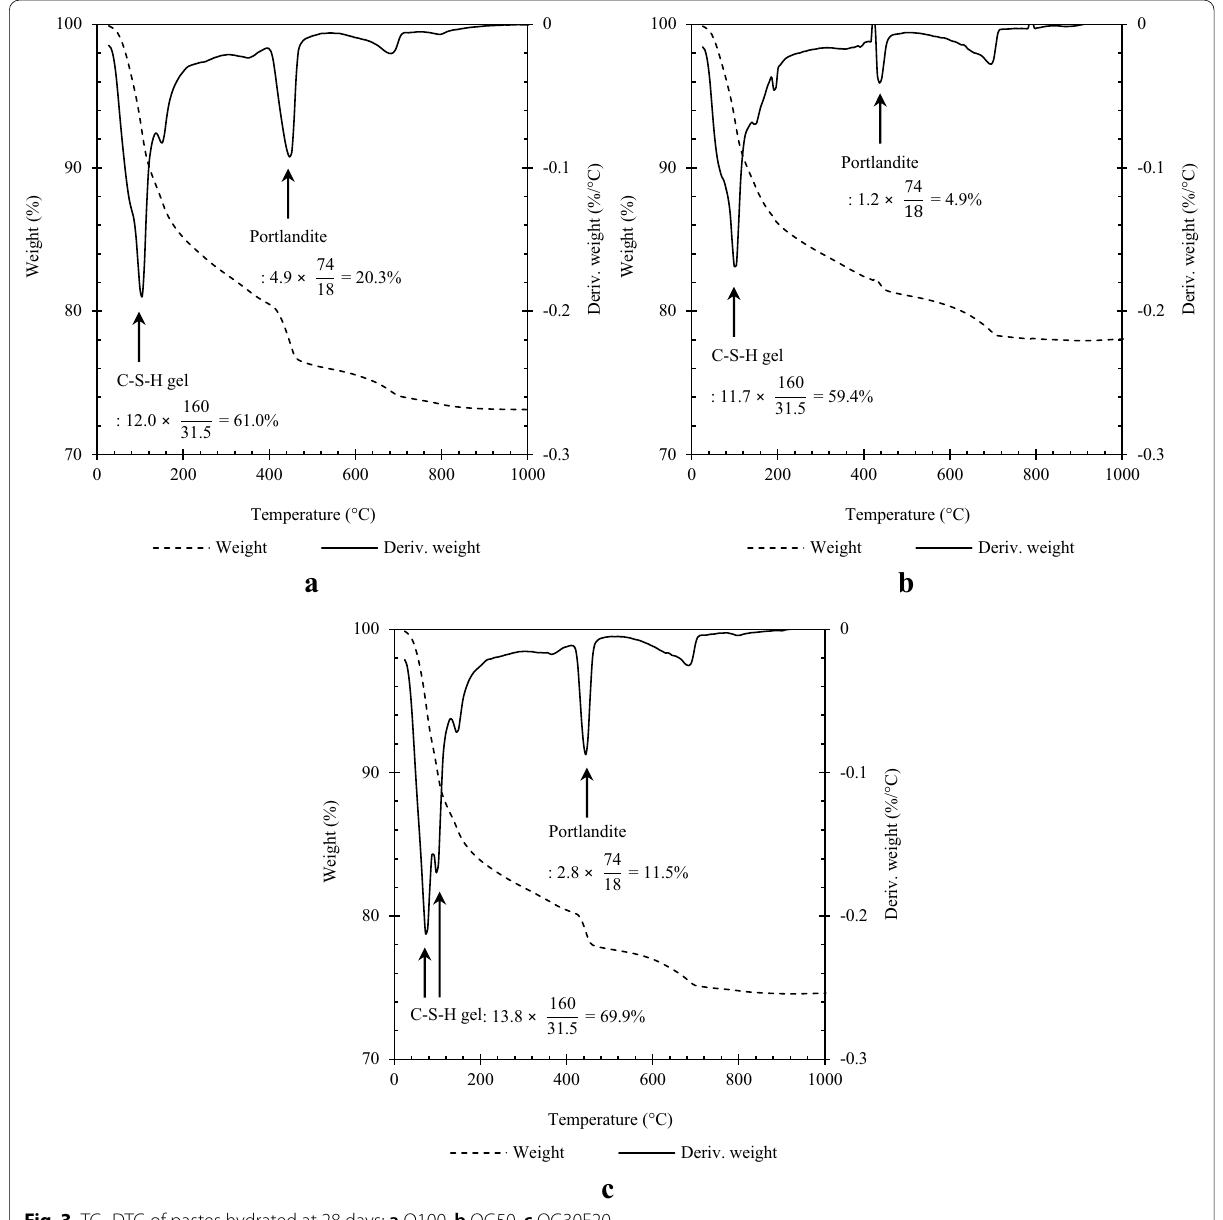
Fig. 3 TG–DTG of pastes hydrated at 28 days: a O100, b OG50, c